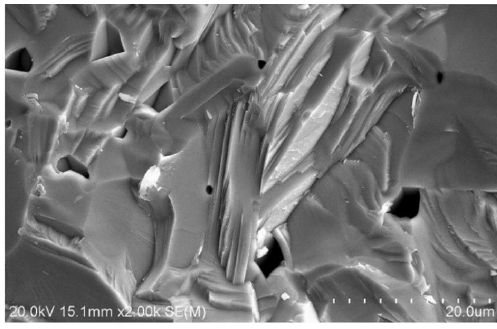
Figure 2. Surface microstructure of La 0.9 Sr 0.1 TiO 3+δ by